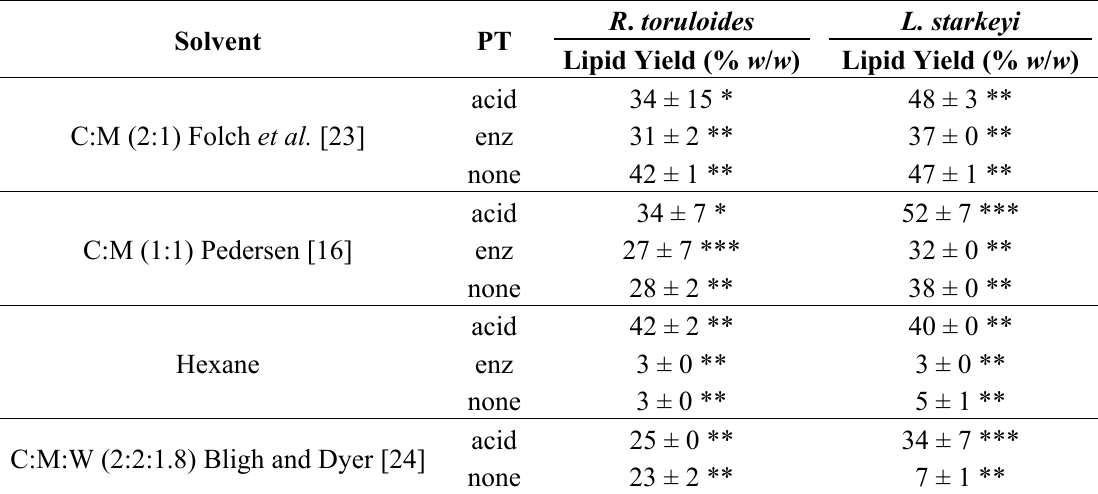
Table 1. Effect of different pretreatments and extraction methods on lipid yield of R . toruloides and L. starkeyi . R . Solvent PT